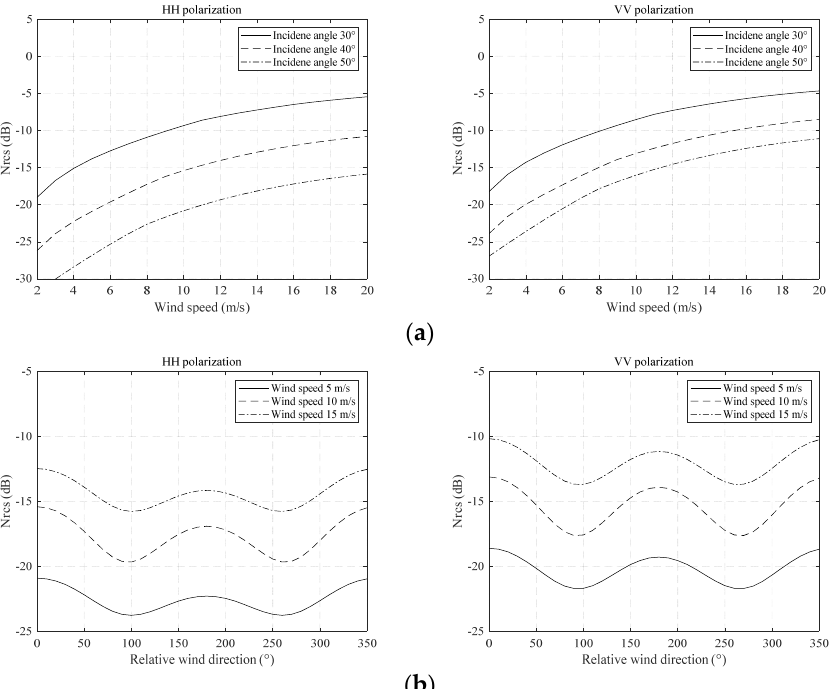
Figure 7. ( a , b ) The NRCS of sea surface variation relative to wind speed and relative wind direction. Wind speed ranges from 2 m/s to 20 m/s and relative wind direction ranges from 0° to 350°. Upper row presents NRCS variation at relative wind direction 0°, lower row presents NRCS variation at incidence 40°.